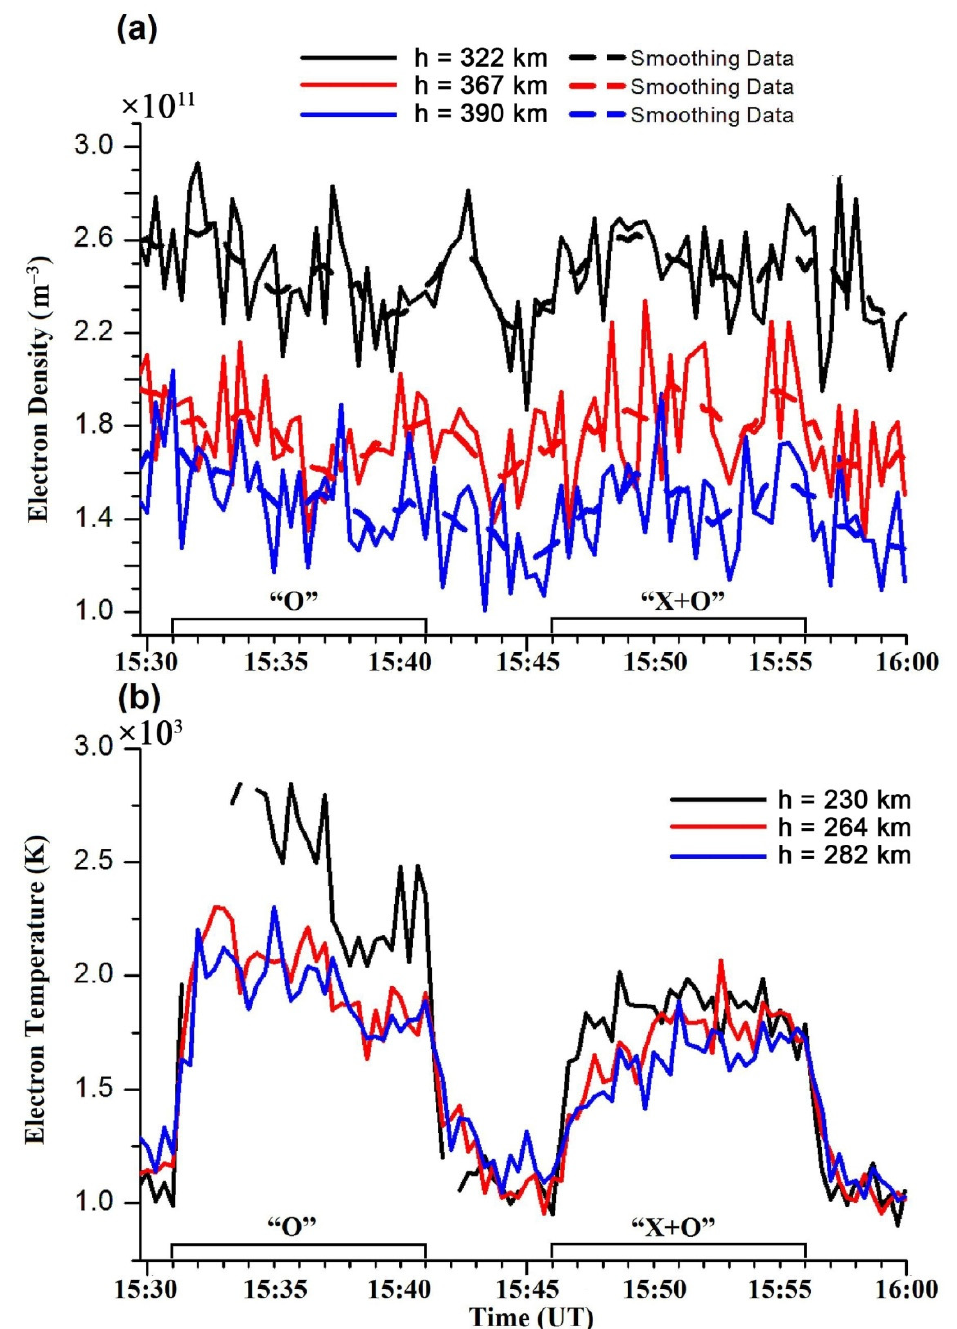
Figure 8. The temporal behavior of ( a ) the electron density and ( b ) electron temperature at fixed heights from the EISCAT radar observations on 28 October 2015 from 15:30 to 16:00 UT. The pump pulses and polarization of the pump wave are shown on the time axis.